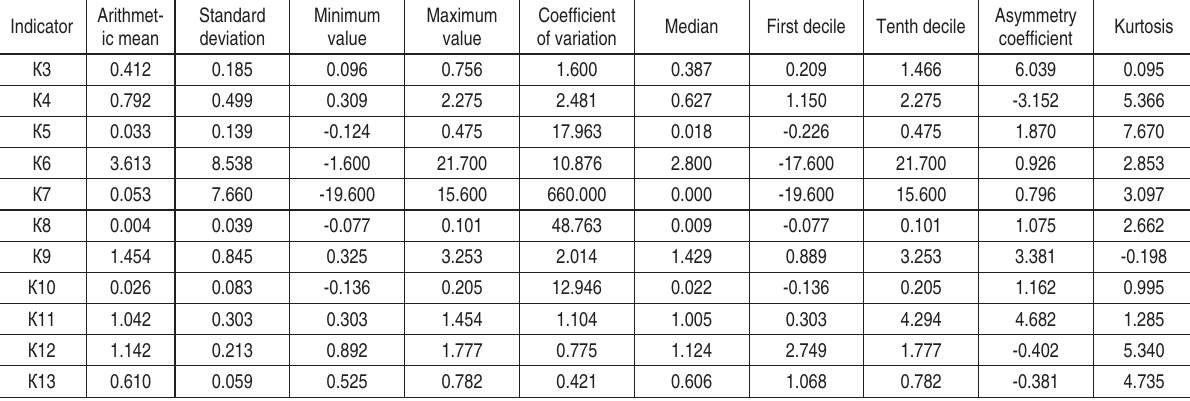
Table 2 (cont.). Statistical analysis of indicators of the financial state of Ukraine’s economy branches Arithmet- Standard Minimum Maximum Coefficient Indicator Median First decile Tenth decile ic mean deviation value value of variation